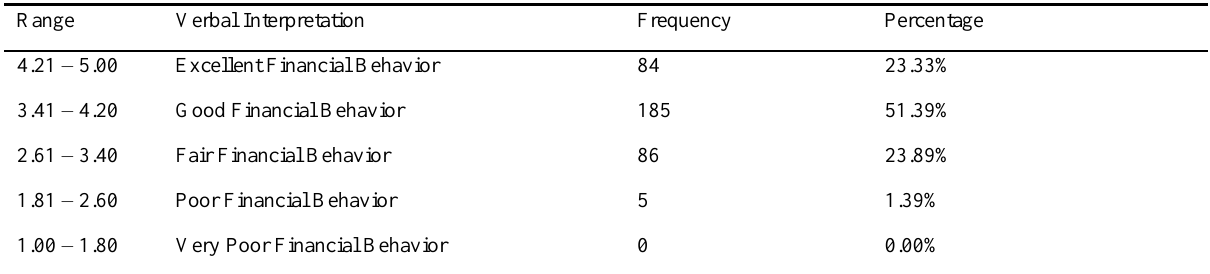
Table 4: Distribution of Teachers According to Financial Behavior.